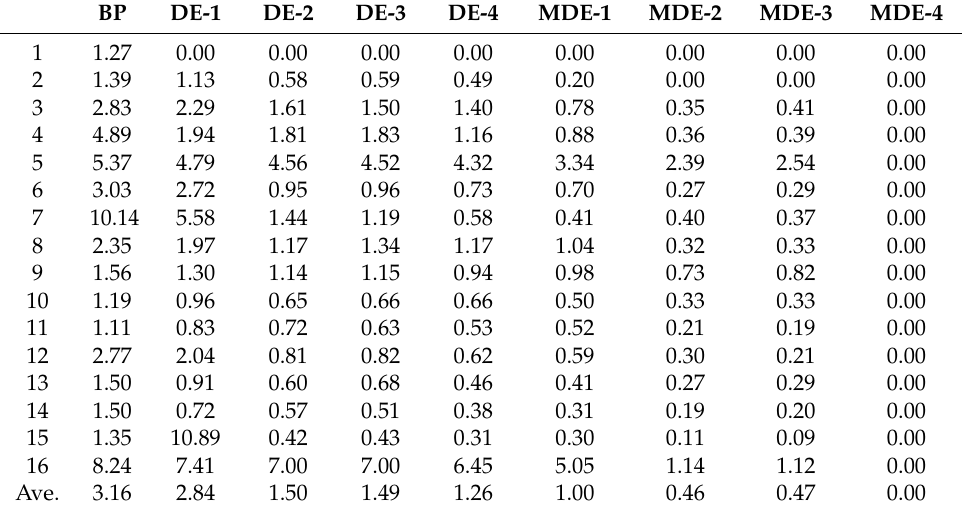
Table 18. Percent difference in a heuristic compared with the best solution compared to all heuristics.